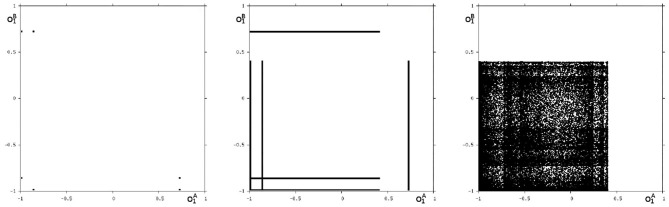
The three asynchronous attractors in M for θ1 = −4: a period-6, and two chaotic attractors. Shown are their projections to the (o1A,o1B)-output space.